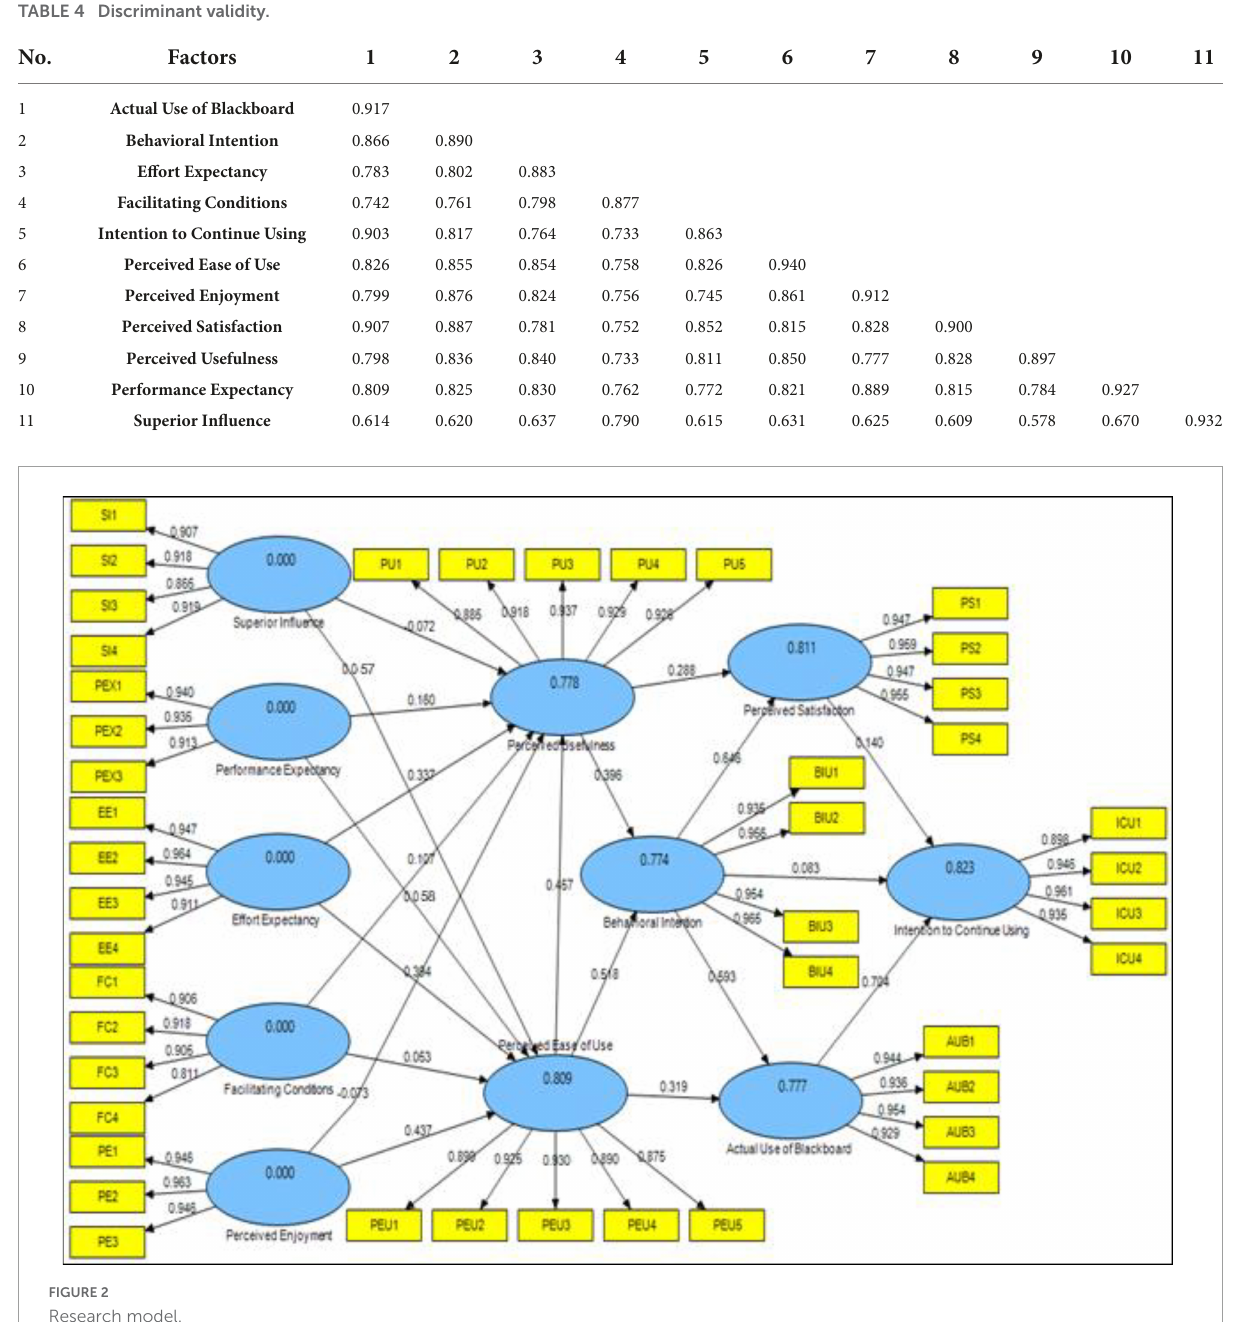
TABLE 4 Discriminant validity.